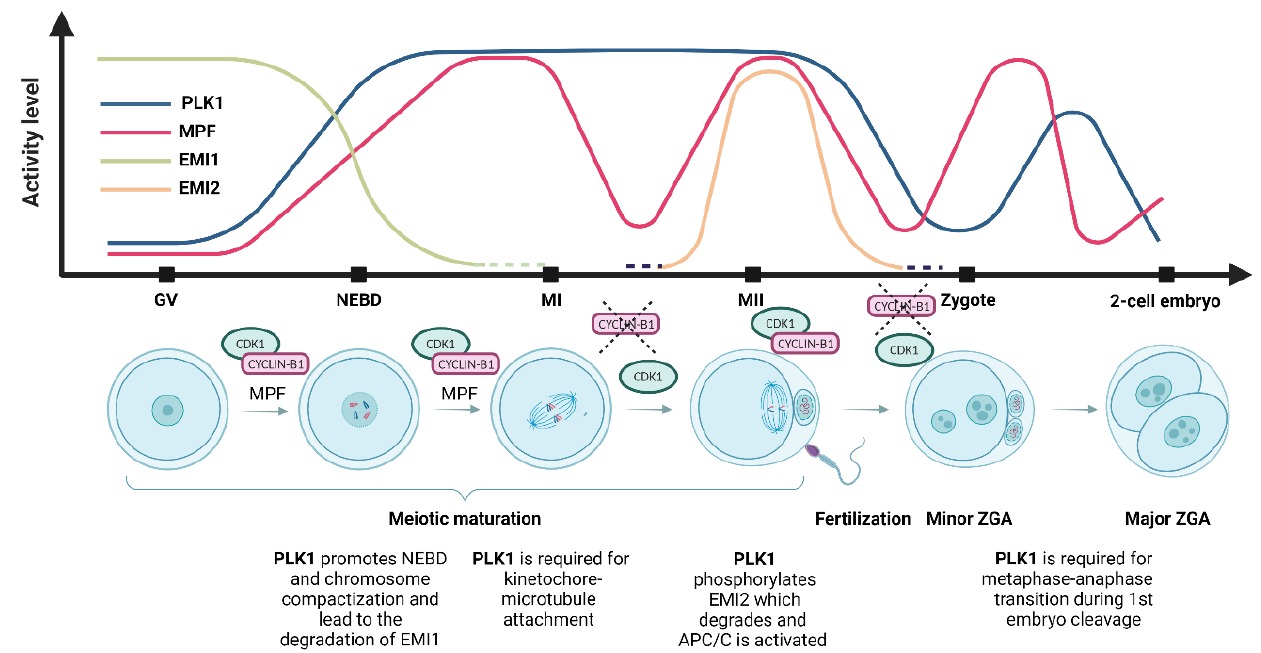
Figure 2. Polo-like kinase 1 (PLK1) and maturation-promoting factor (MPF) activity and the level of early mitotic inhibitor 1 (EMI1) and early mitotic inhibitor 2 (EMI2) during meiotic maturation and oocyte-to-embryo transition. During the first meiotic arrest at the germinal vesicle (GV) stage, PLK1 activity is at very low levels. PLK1 activity starts to increase before nucleus envelope breakdown (NEBD), the inhibition of the anaphase-promoting complex (APC/C) by EMI1 leads to the accumulation of cyclin B, and the activity of the MPF increases. During NEBD, chromosome